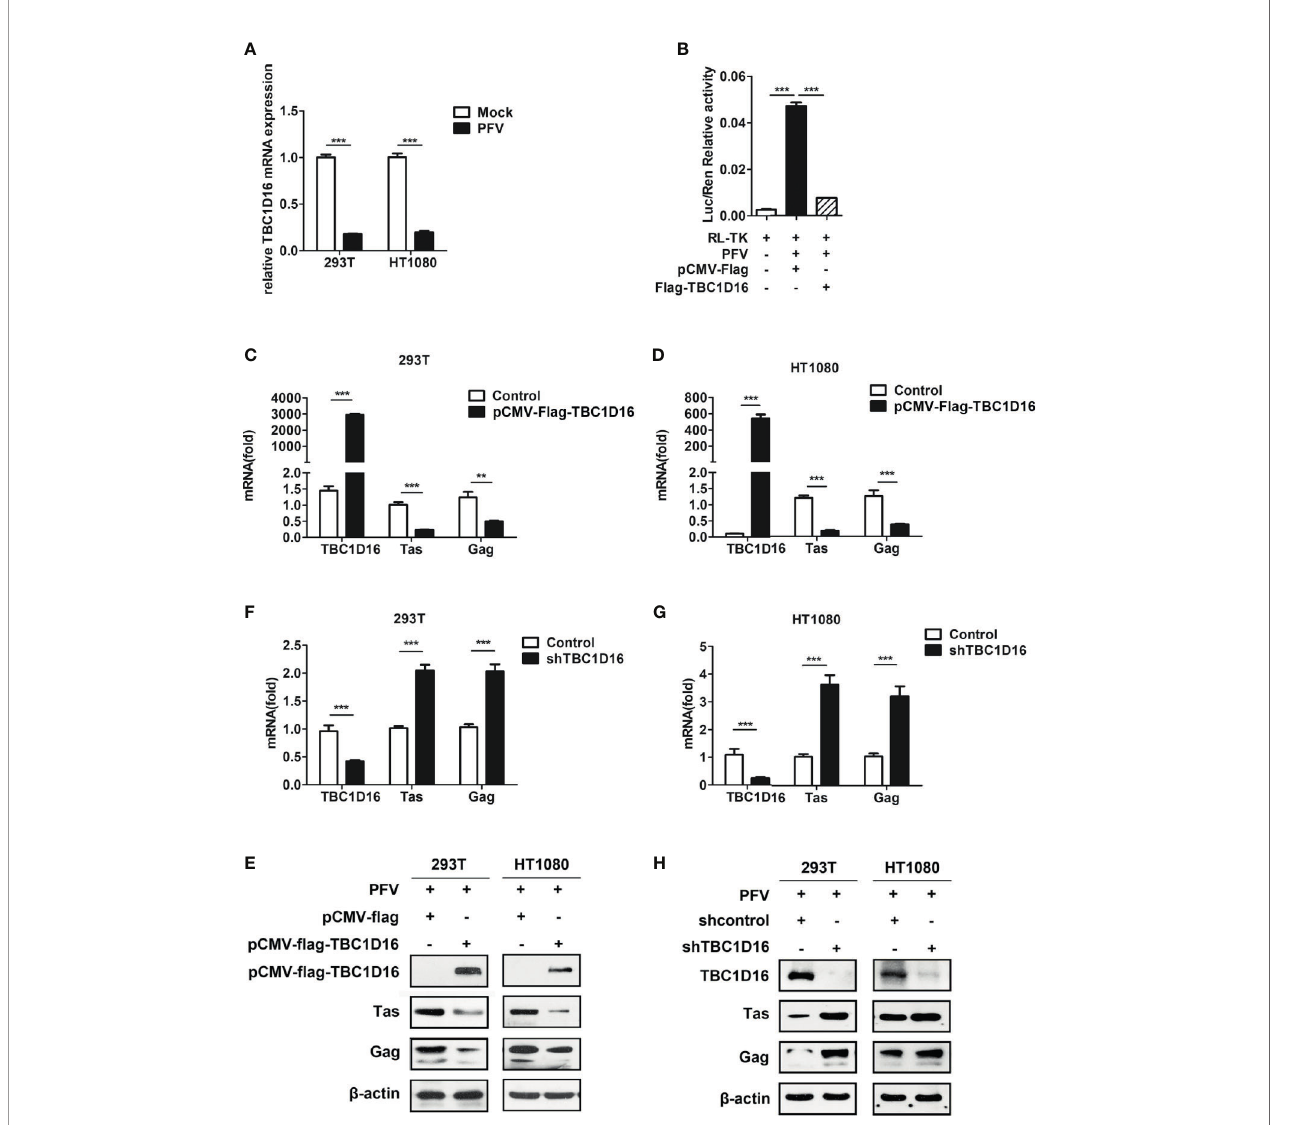
FIGURE 2 | TBC1D16 inhibits the replication of PFV. (A) After infection with PFV (MOI = 0.5) for 48 h, the mRNA expression of TBC1D16 in HEK293T and HT1080 cells was detected by qPCR (*** p < 0.001). (B) The relative viral load in the presence or absence of overexpressed TBC1D16 was analyzed in PFV indicator cell line. RL-TK (1.5 m g) was transfected as an internal control. (C, D) pCMV-Flag-TBC1D16 or pCMV-Flag (as an empty control) were transfected into HEK293T and HT1080 cells for 24 h. After transfection, the cells were infected with PFV (MOI = 0.5) for 48 h. The mRNA or protein expression of PFV Tas and Gag was detected by qPCR (** p < 0.01 and *** p < 0.001). (E) pCMV-Flag-TBC1D16 or pCMV-Flag (as an empty control) were transfected into HEK293T and HT1080 cells for 24 h. After transfection, the cells were infected with PFV (MOI = 0.5) for 48 h. The protein expression of PFV Tas and Gag was detected by western blotting. (F, G) The speci fi c shRNA and shControl (as a negative control) were transfected into HEK293T and HT1080 cells for 24 h to knock down the expression of TBC1D16 and then were infected with PFV (MOI = 0.5) for 48 h. The mRNA expression of PFV Tas and Gag was detected by qPCR (*** p < 0.001). (H) The speci fi c shRNA and shControl (as a negative control) were transfected into HEK293T and HT1080 cells for 24 h to knock down the expression of TBC1D16 and then were infected with PFV (MOI = 0.5) for 48 h. The protein expression of PFV Tas and Gag was detected by western